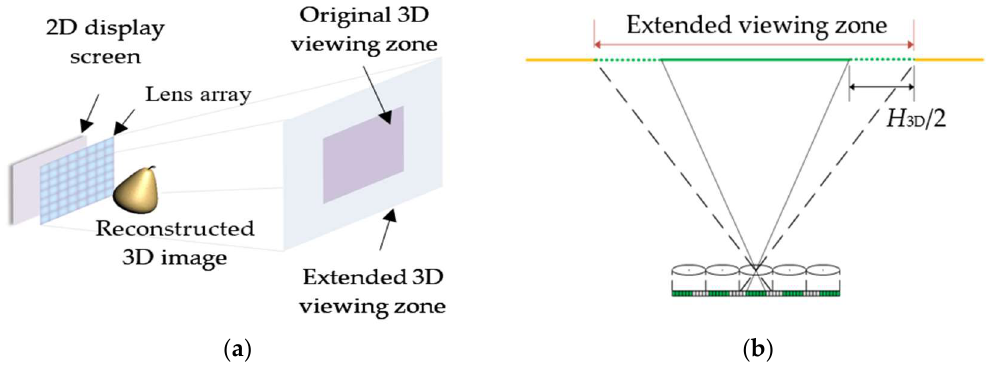
Figure 3. ( a ) Structure and ( b ) extended viewing zone of the proposed InIm system.